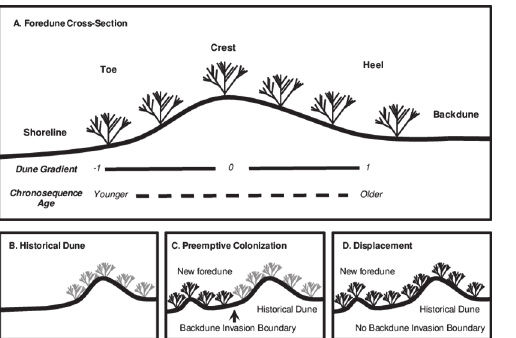
Fig 1. Foredune cross-section schematics. (A) Foredunes contain both spatial and temporal gradients along their cross-sections. Foredune consists of toe, crest, and heel moving from left to right. For the spatial dune gradient, quadrats were assigned values between-1 and 1 for their placement along the dune cross- section. Chronosequence age increased from the dune toe to heel (see main text for details). Shoreline and backdune are shown for orientation. (B) Historical dune consisting of only Ammophila arenaria (gray). (C) Invasion of historical dune by A . breviligulata (black) through preemptive colonization of a new dune. Ammophila arenaria retains its original population, and a backdune invasion boundary delineates the two species ’ distributions along the dune. (D) Invasion of historical dune by A . breviligulata through displacement of A . arenaria . Note that there is no longer a backdune invasion boundary because the A . arenaria has been locally